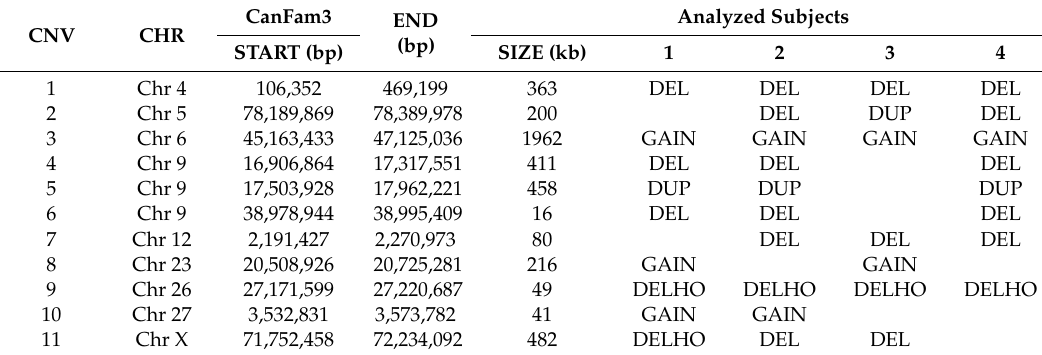
Table 3. CGH-array